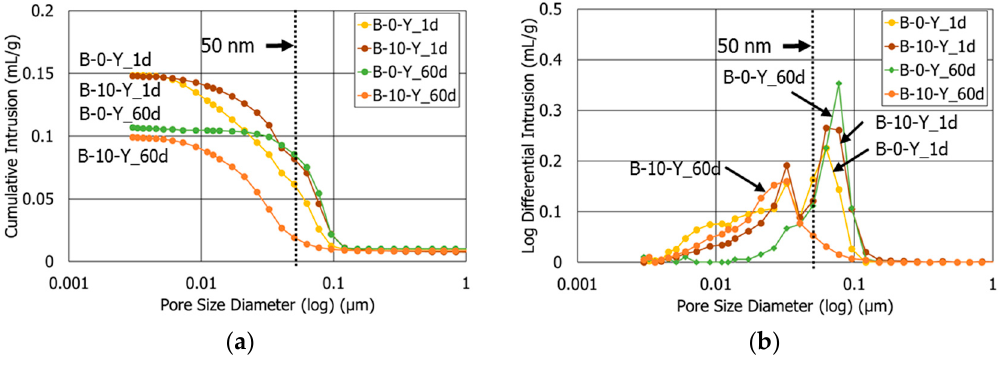
Figure 6. The pore size distributions of mixtures B-0-Y and B-10-Y at different ages (1 d, 60 d): ( a ) cumulative intrusion; ( b ) log differential intrusion (unit: mL/g).